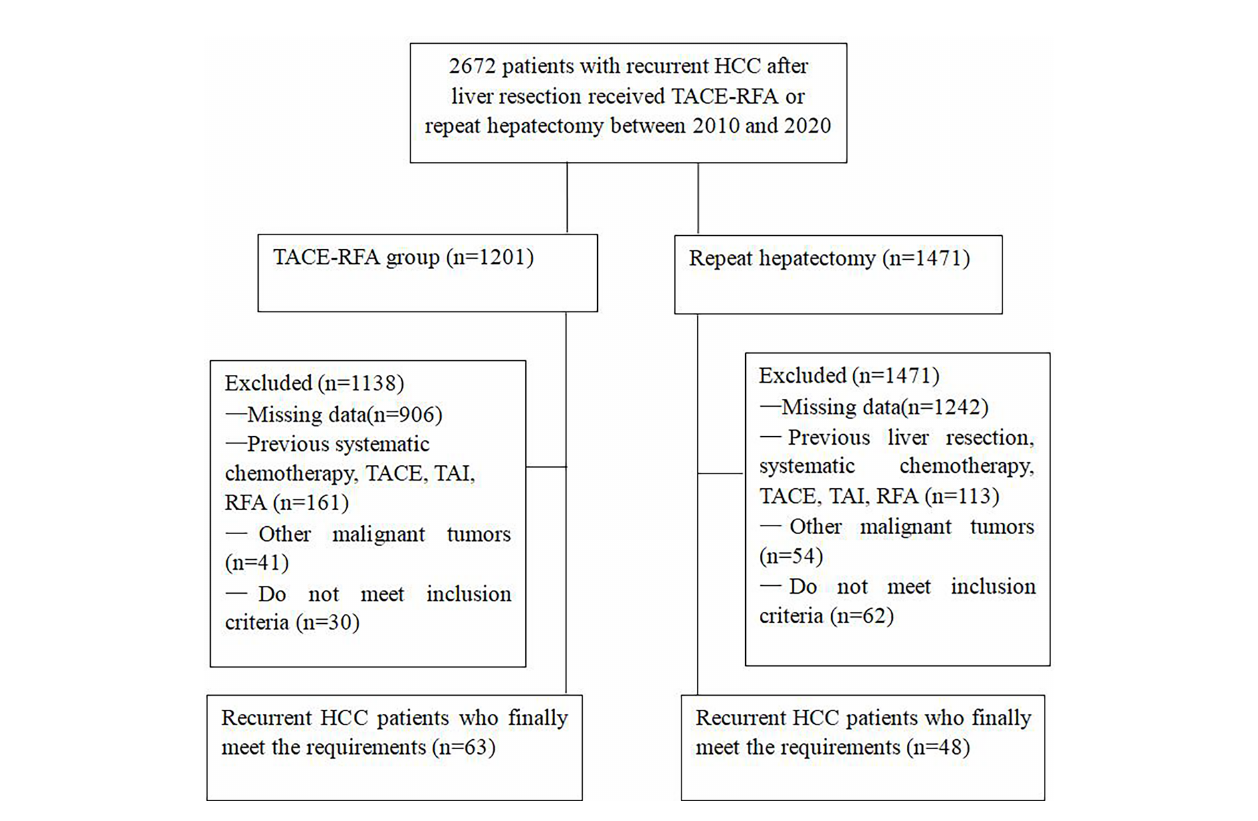
FIGURE 1 | Flow chart shows the screening procedure for recurrent HCC patients after curative